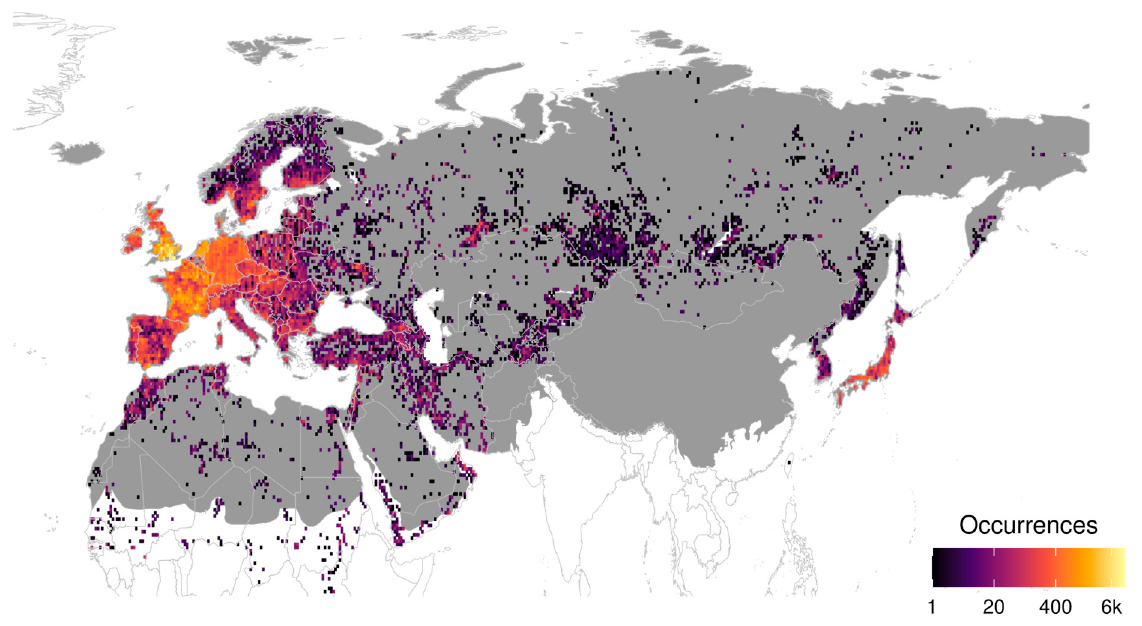
Figure 5. Odonata sampling effort in the Palaearctic.